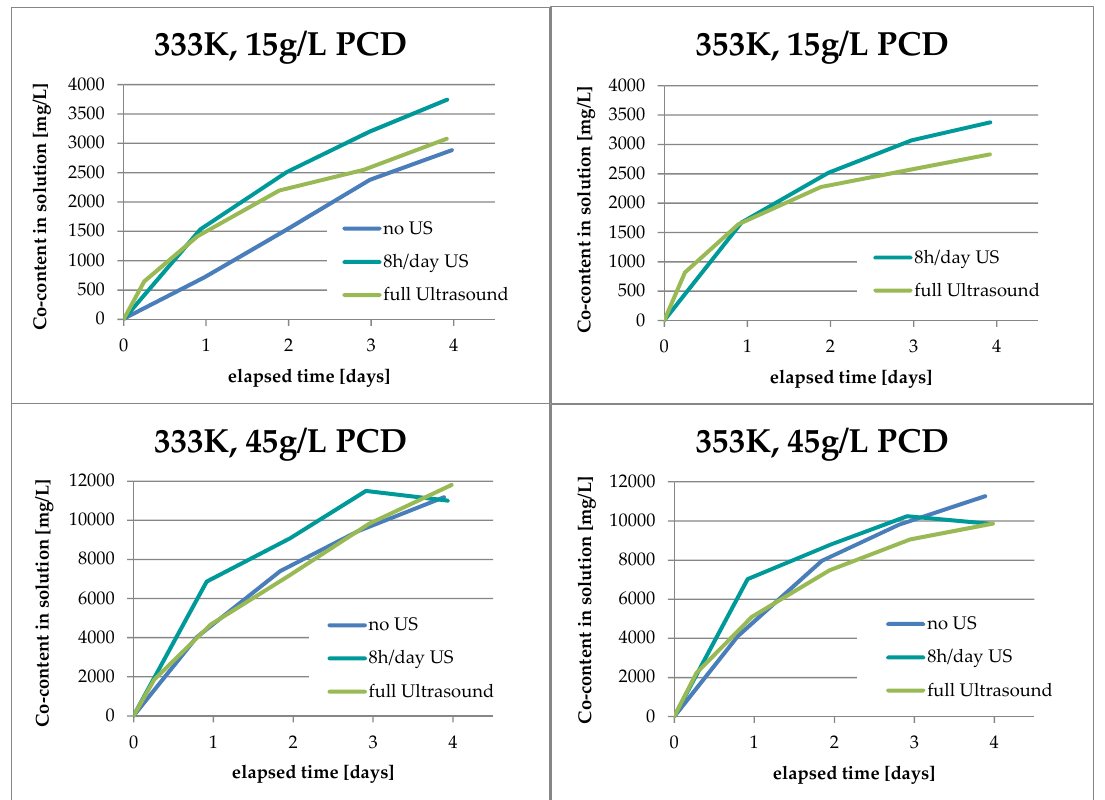
Figure 9. Influence of ultrasound on concentration of cobalt in the solution over time.